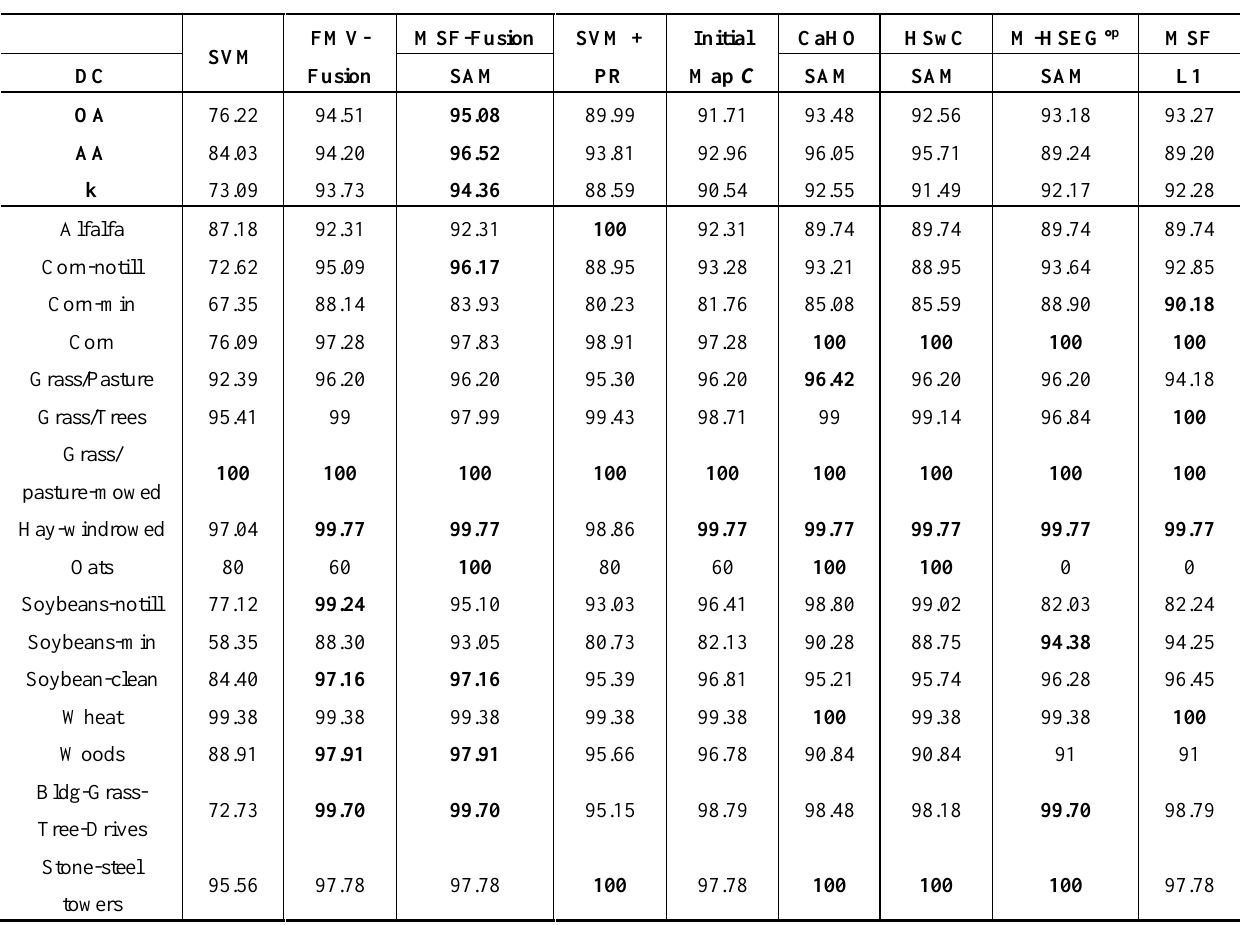
Table 3. Classification accuracies for the Indiana